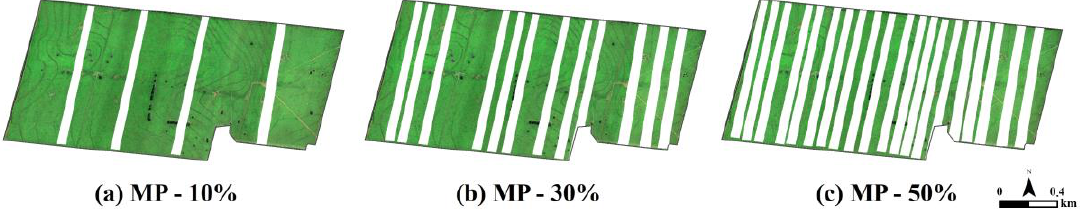
Figure 4. Simulation of the missing parts (white strips) in the original UAV orthomosaic: ( a ) missing part of 10% — MP-10%, ( b ) missing part of 30% — MP-30%, ( c ) missing part of 50% — MP-50%.